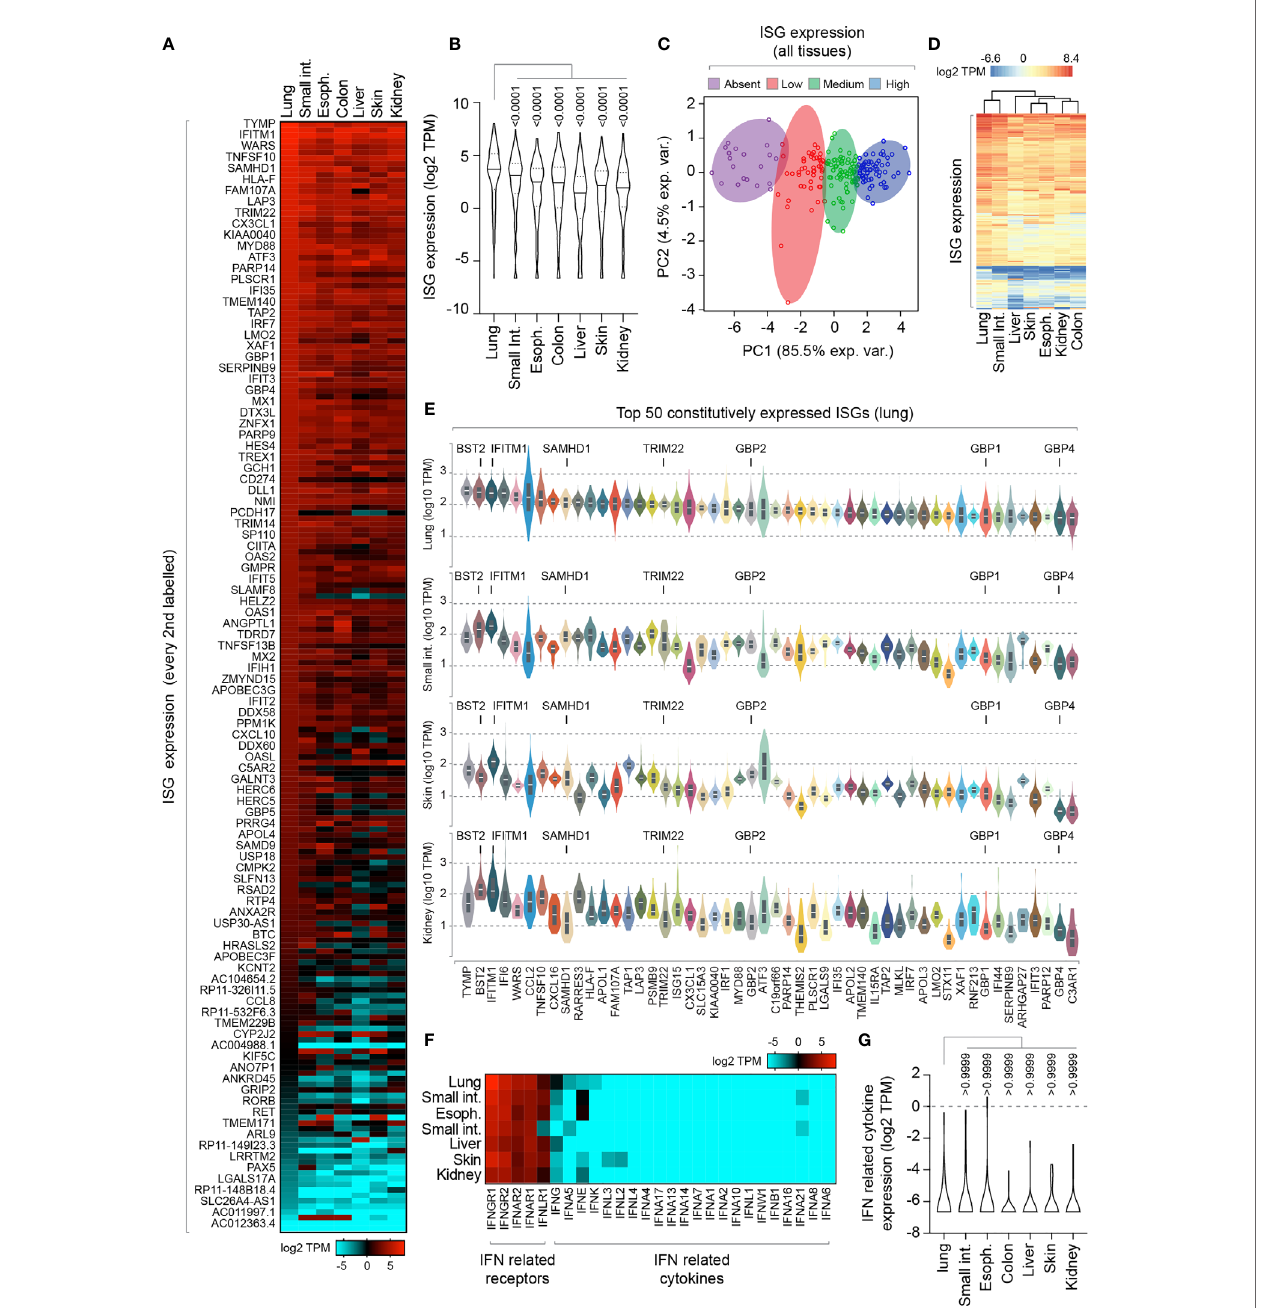
FIGURE 1 | Lung tissue is enriched for constitutive ISG expression relative to other mucosal and non-mucosal tissues. (A) Heat map showing the constitutive expression pro fi le (log2 transcripts per million; TPM) of 200 ISGs across a range of human mucosal and non-mucosal tissues; lung (n=427), small intestine (Int.; terminal ileum; n=137), esophagus (Espho.; mucosa; n=407), colon (sigmoid; n=233), liver (n=175), skin (suprapubic; n=387), and kidney (cortex; n=45). Every second ISG labelled (individual values shown in Supplemental Table S1A ). (B) Violin plot showing tissue ISG expression pro fi les (as in A ). Horizontal solid lines; median ISG expression per tissue. Horizontal dotted lines; 5 th and 95 th percentile range per tissue. (C) Principle component (PC) analysis of ISG expression levels across all tissues (as in A ). (D) Heatmap showing clustered relationship of ISG expression levels between different tissues (as in A ). (E) Violin plots showing the top 50 constitutively expressed ISGs in the lung relative to small intestine, skin, and kidney tissues. White line; median. Box; 5 th and 95 th percentile range. (F) Heat map showing the expression pro fi le (log2 TPM) of IFN-related receptors and cytokines per tissue (as in A ; values shown in Supplemental Table S1B ). (G) Violin plot showing IFN-related cytokine expression pro fi le (as in F ). Horizontal solid lines; median. Horizontal dotted lines; 5 th and 95 th percentile range. (E, F) Paired one-way ANOVA (Friedman multiple comparison test); p-values shown. RNA-Seq data adapted under creative commons licence from GTEx portal [https://gtexportal.org/home/; (Carithers et al.,